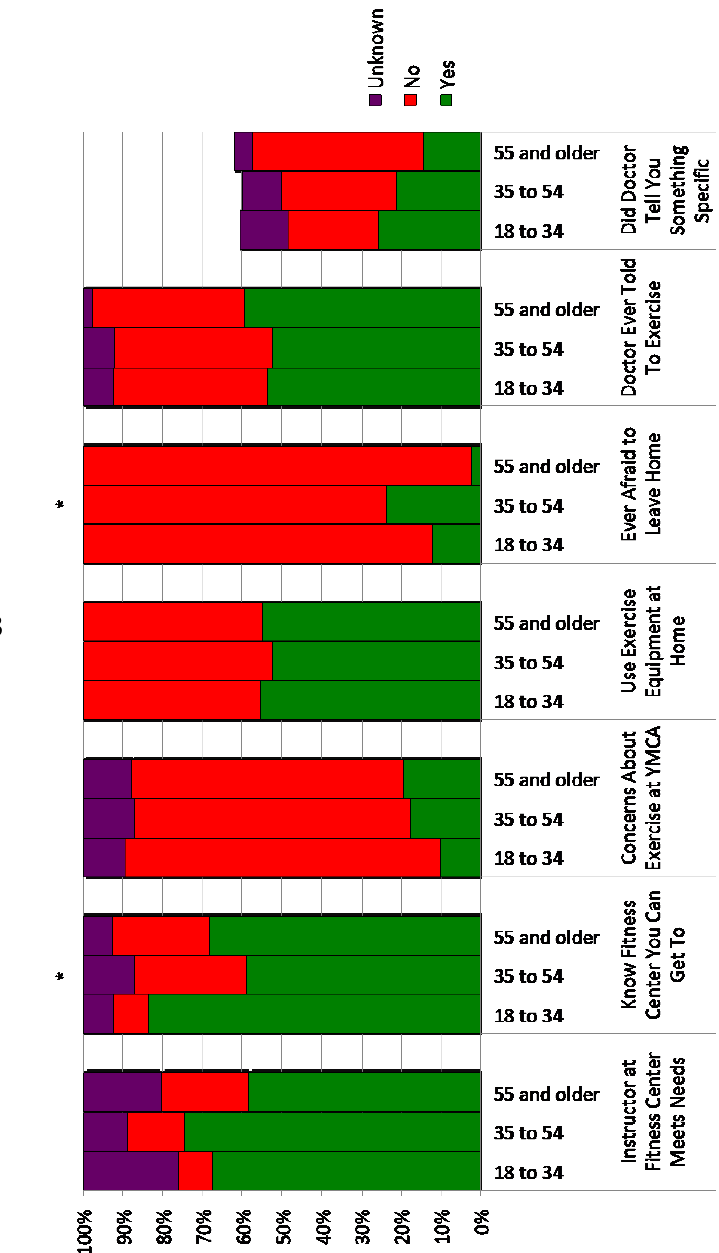
Figure 1. Reported barriers to exercise based on age. * p -value < 0.05. ( A , B ) represent different parts of the survey.